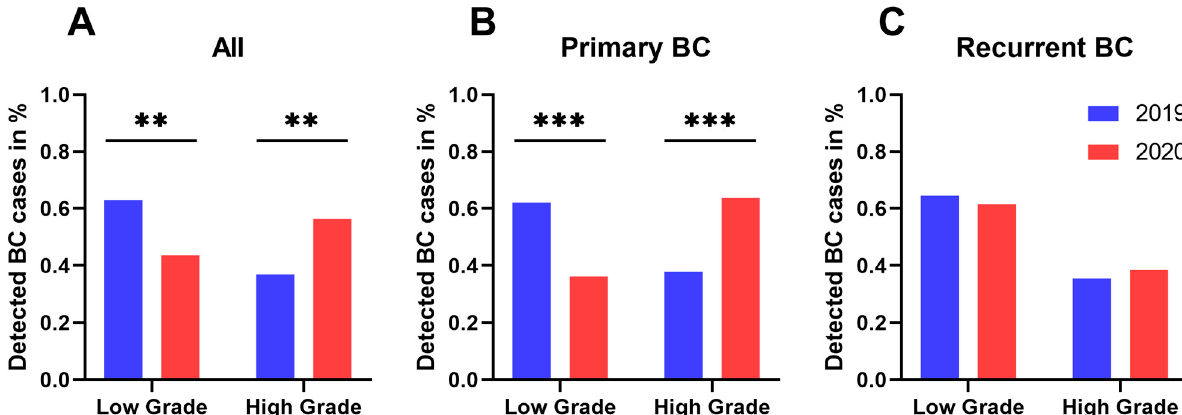
Figure 4. Tumor grading compared between 2020 and 2019. ( A ) total BC population ( n [2019] = 165; n [2020] = 133), ( B ) patients with primary BC ( n [2019] = 103; n [2020] = 94), and ( C ) patients with recurrent BC during oncological follow-up ( n [2019] = 62; n [2020] = 39). ** p < 0.01; *** p < 0.001.